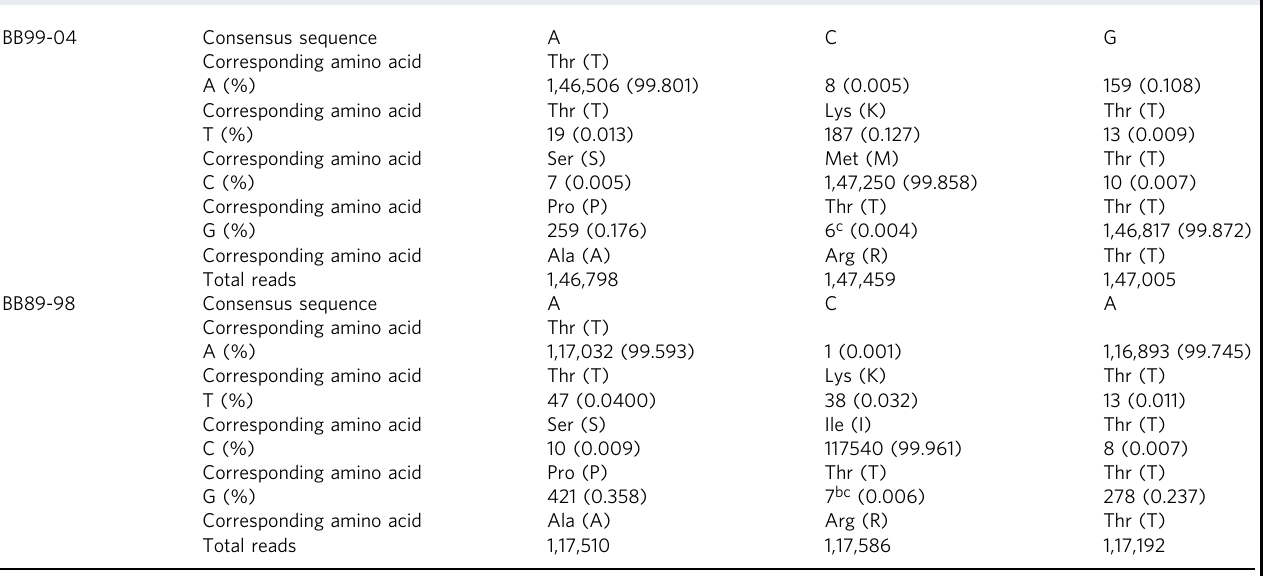
a Spike position Thr672 corresponds to the European SrC BB99-04 (GenBank Acc. No. KR559017). b One of the reads was not paired-end. c This singe nucleotide variant leads to a non-synonymous exchange generating an FCS motif in this